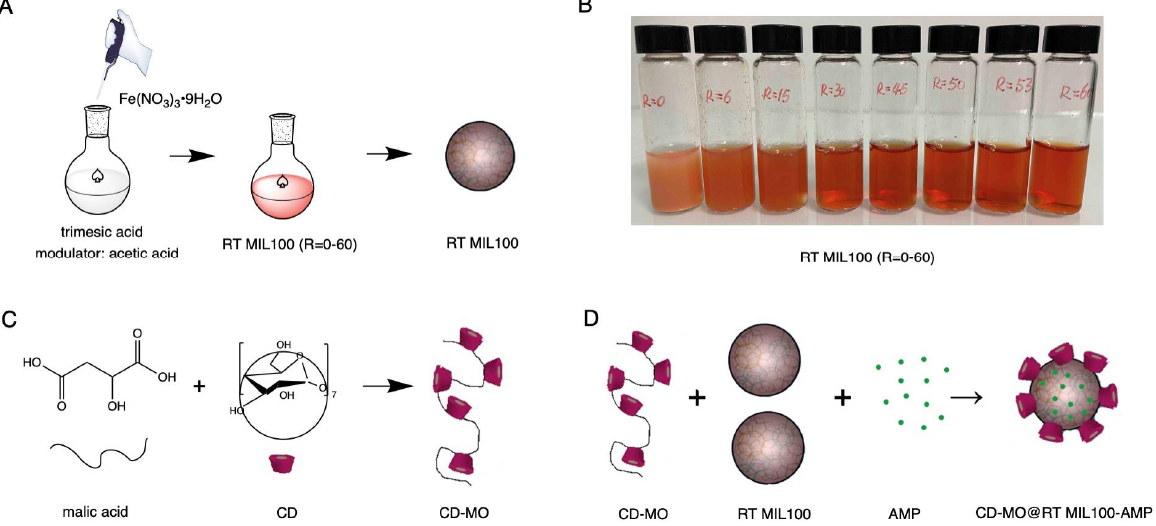
Figure 1. Schematic representation of the synthesis of ( A ) RT MIL100 using acetic acid as a modulator, trimesic acid as an organic linker, and iron (III) nitrate; ( B ) photos of the reaction mixtures immediately after mixing the reactants. Effect of the amount of modulator on the color and turbidity of the reaction mixture. The color variation of modulated RT MIL100 (R = 0–60); ( C ) CD-MO oligomers obtained by crosslinking CD with malic acid; ( D ) core-shell and drug-loaded nanoparticles (CD-MO@RT MIL100-AMP) obtained by simply mixing the components of the system at room temperature and in